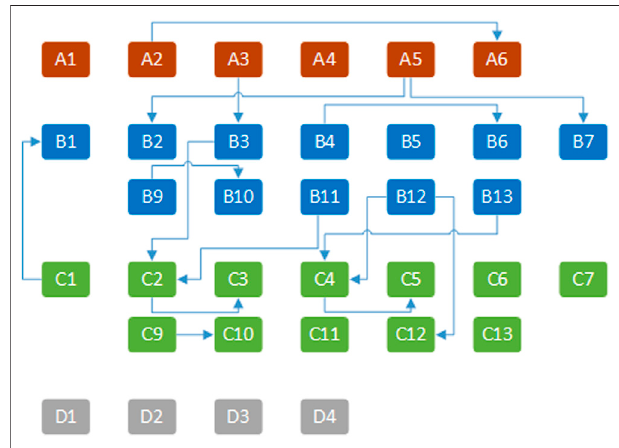
FIGURE 2 | Behavioral transfer diagram for colleges.